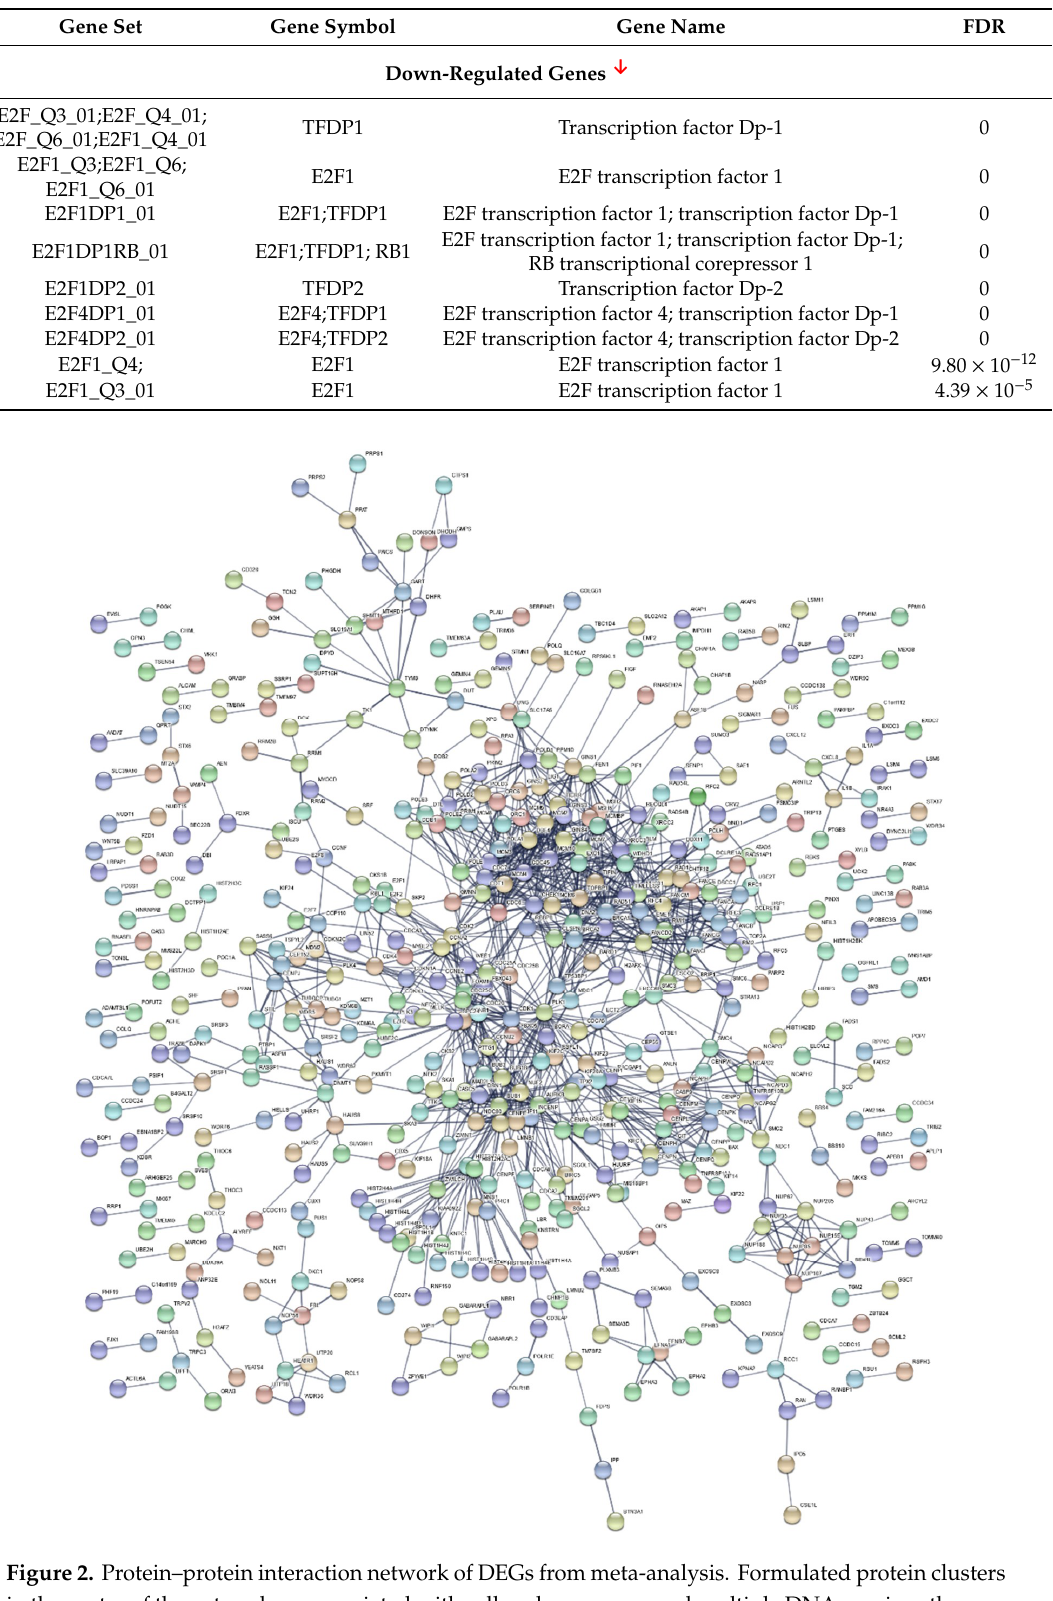
Figure 2. Protein–protein interaction network of DEGs from meta-analysis. Formulated protein clusters in the center of the network are associated with cell cycle processes and multiple DNA repair pathways.